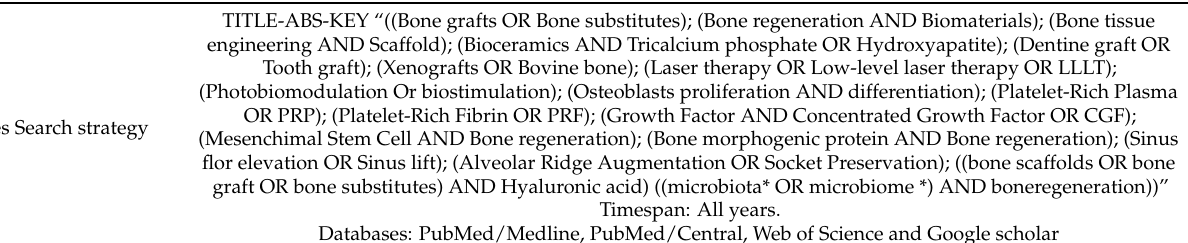
Summary of the electronic databases Boolean search strategy (PubMed/Medline, PubMed/Central, Web of Science; Google scholar). No limitation about the publication years